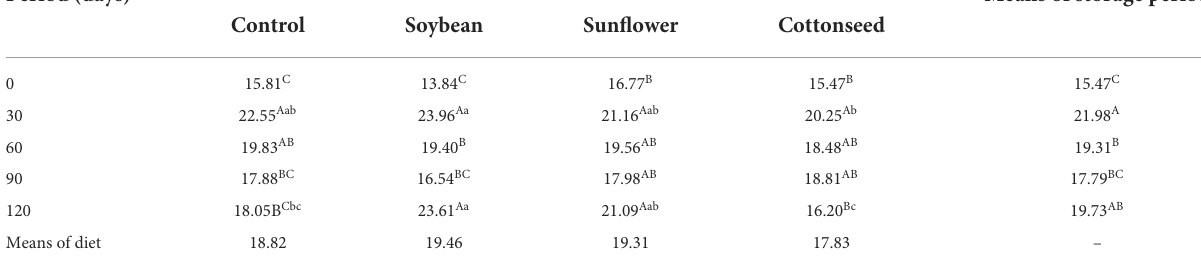
TABLE 4 Effect of storage period on intensity of the a * parameter in burgers produced by meat of steers fed with different oilseeds sources, and interactions between factors. Period